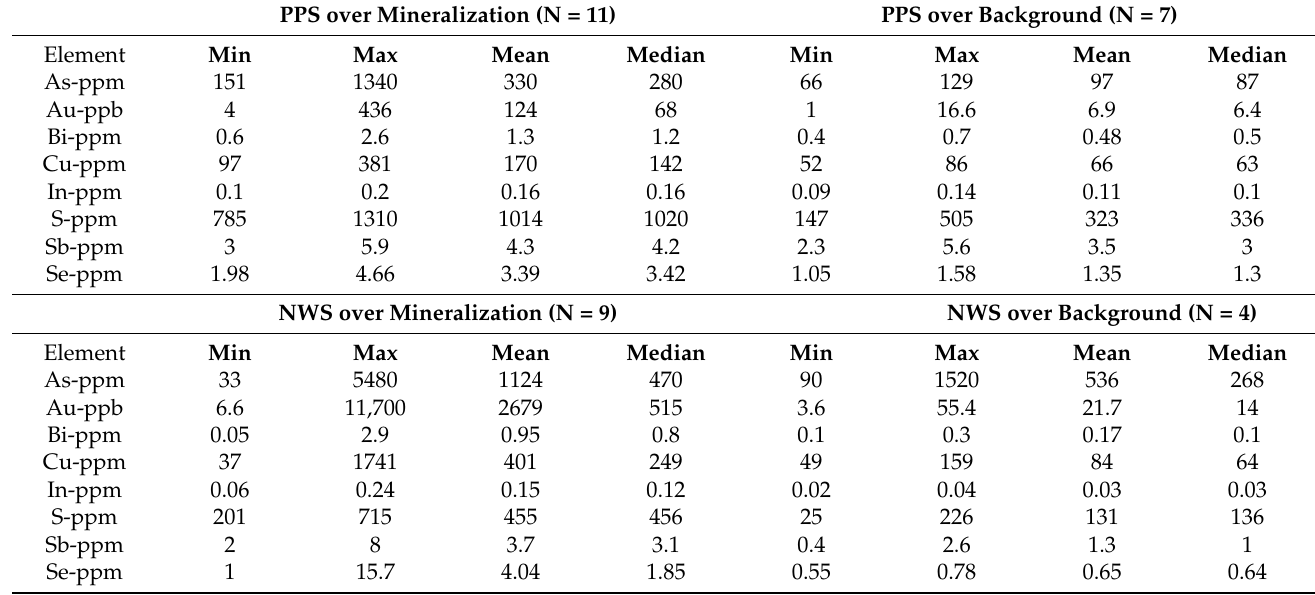
Table 1. Summary statistics of selected elements for the PPS and